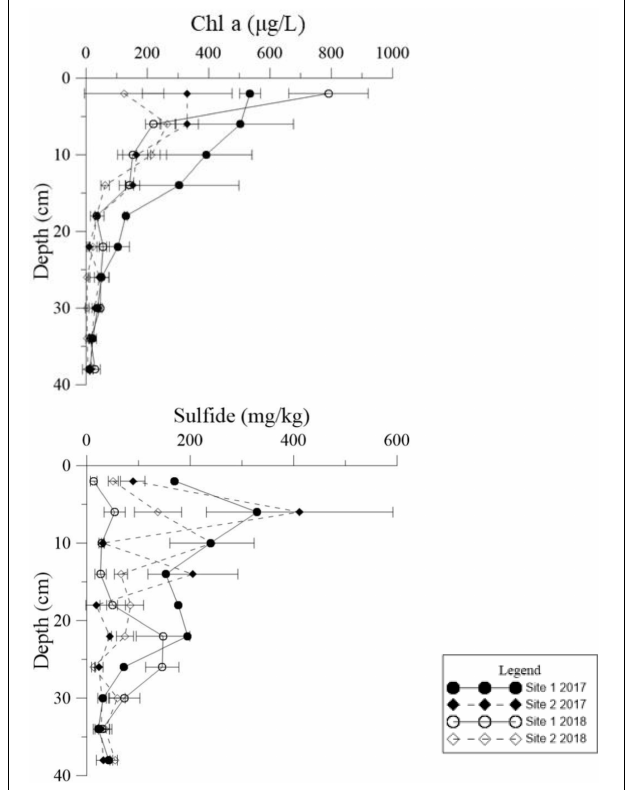
FIGURE 5 | Vertical distributions of Chl a and sulfide in the deep sediment cores from the two study sites in May 2017 and May 2018.